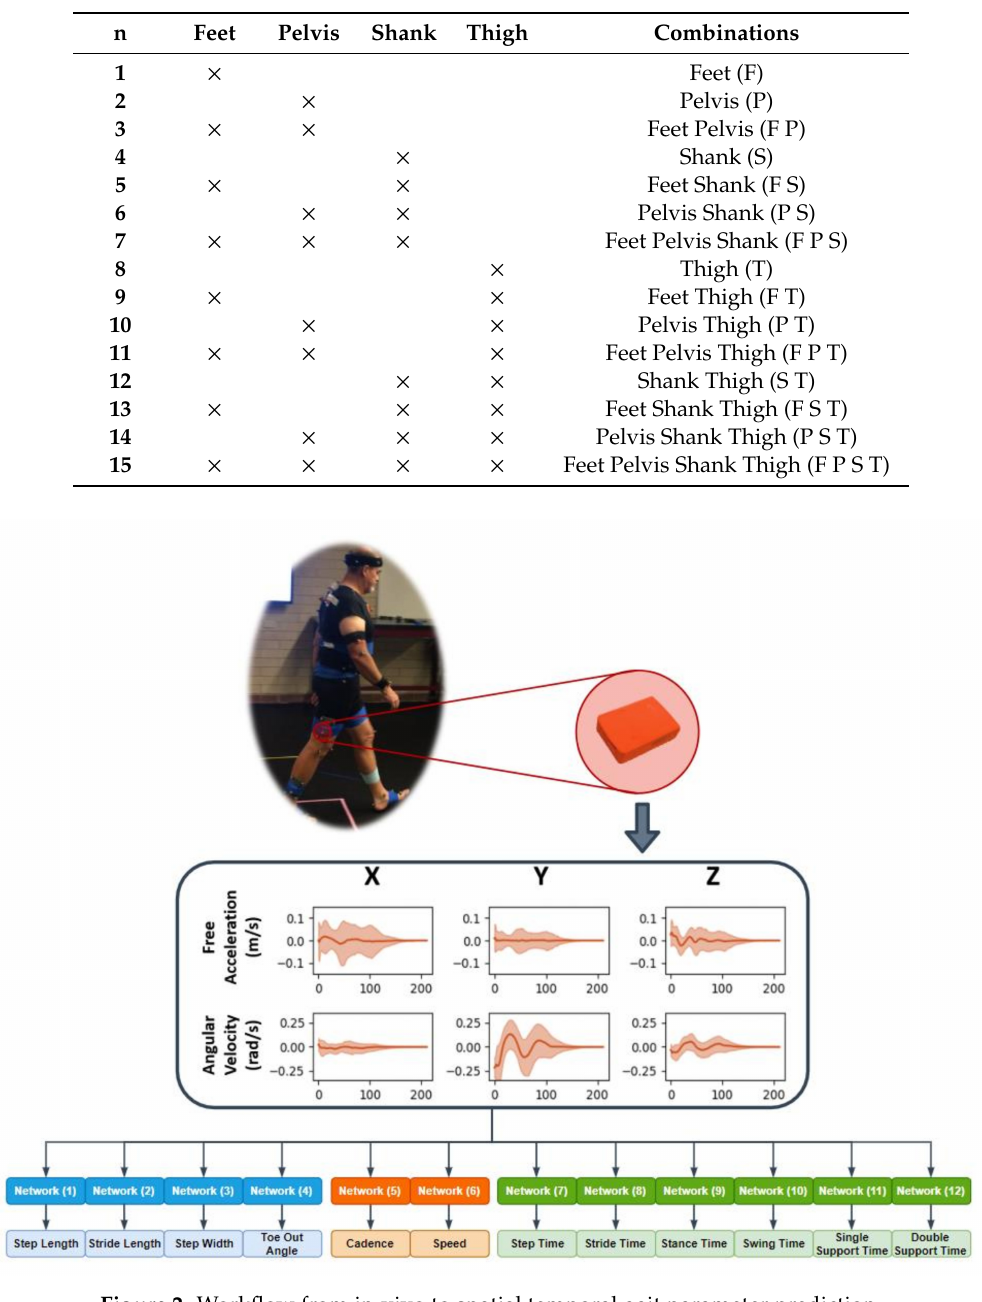
Figure 2. Workflow from in-vivo to spatial temporal gait parameter